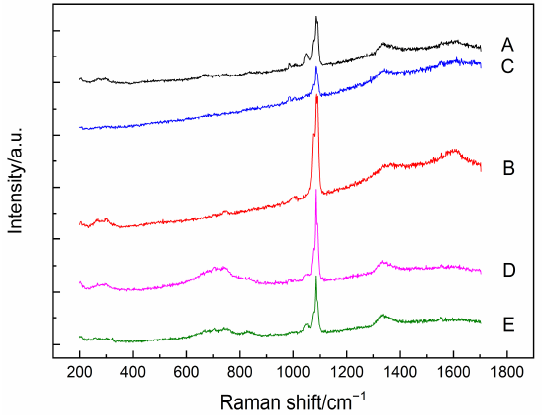
Figure 2. Raman spectra of the analyzed points (A–E) as shown in Figure 1.